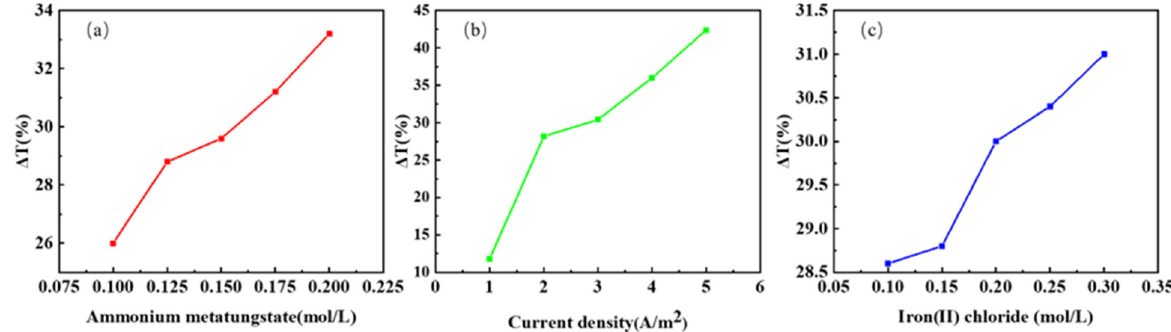
Figure 5. The mean main effect diagrams of different factors for Δ T: ( a ) ammonium metatungstate; ( b ) current density; ( c ) iron (II) chloride.